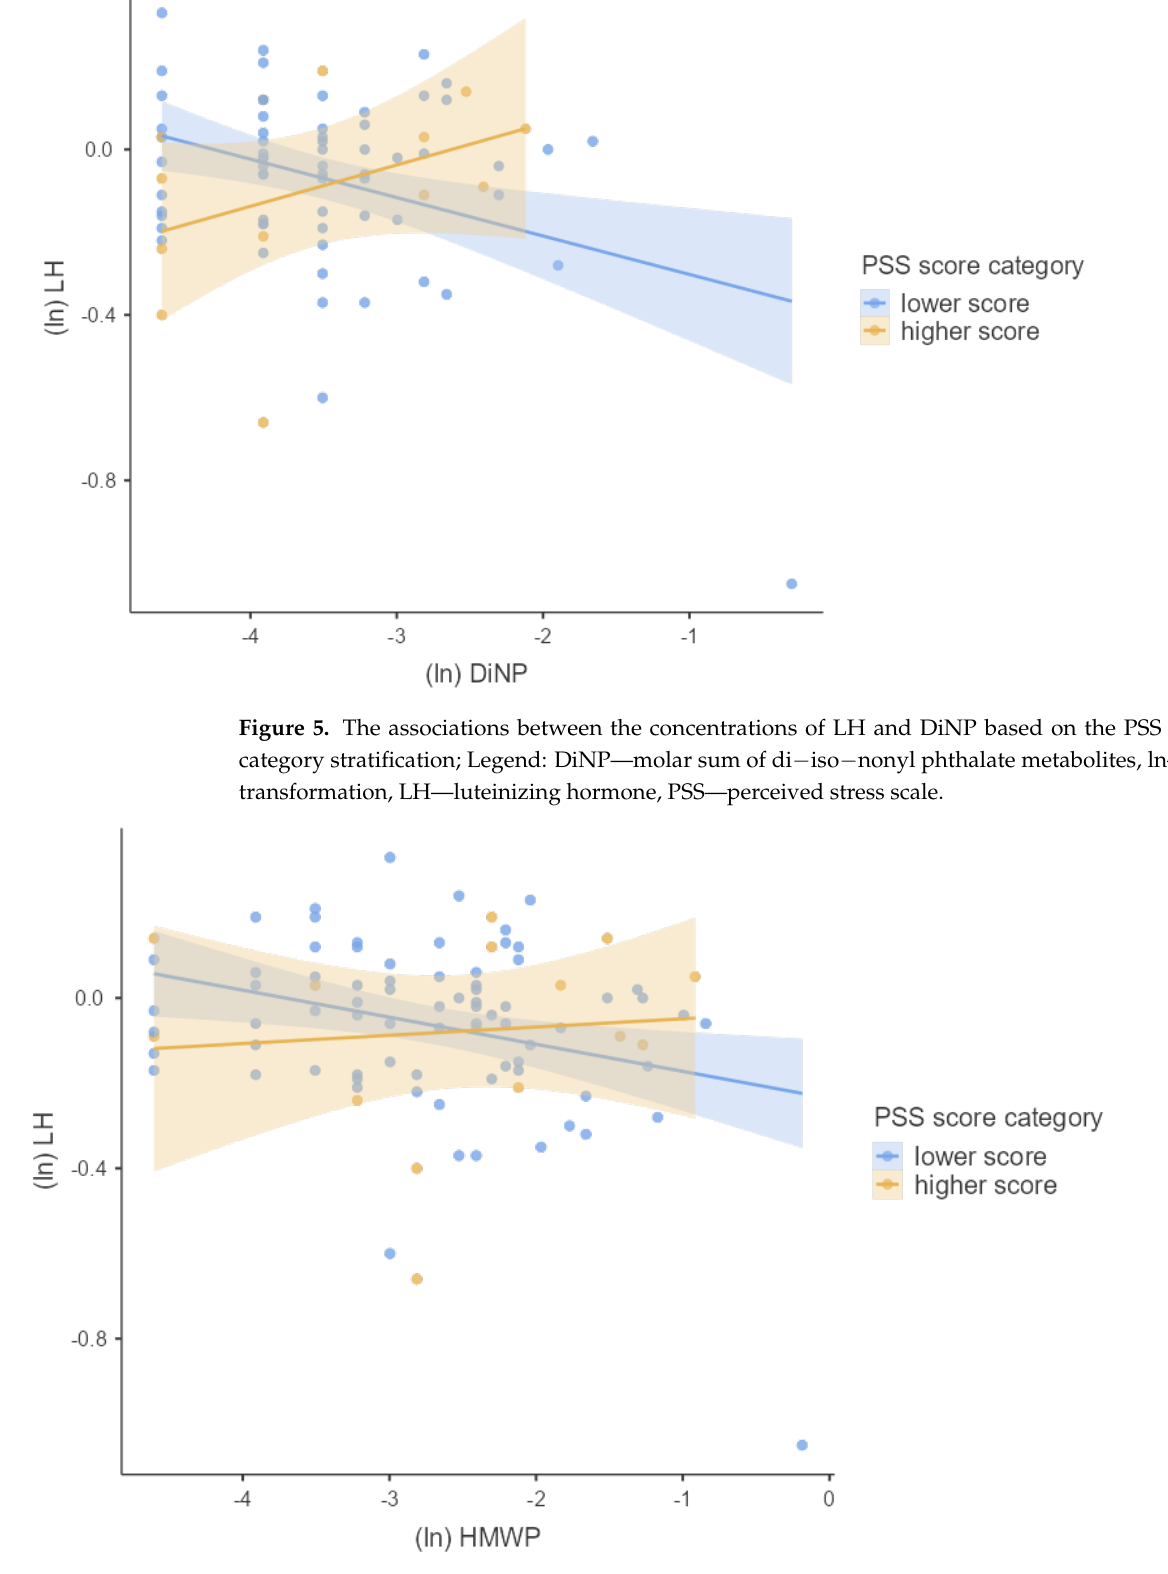
Figure 6. The associations between the concentrations of LH and HMWP based on the PSS score category stratification; Legend: HMWP — molar sum of high − molecular − weight phthalate metabo- lites, ln — log transformation, LH — luteinizing hormone, PSS — perceived stress scale. When comparing the difference between the main effect of PSS score or phthalate metabolites separately and their interaction effect on hormonal concentrations, the asso- ciations with estradiol disappeared. Contrary, more associations with LH appeared sig- nificant, but they changed their direction from negative to positive associations. 4. Discussion Several studies have simultaneously examined xenobiotic-induced and psychosocial stress in pregnant women [29 – 32]. To our knowledge, only one examined the effects of